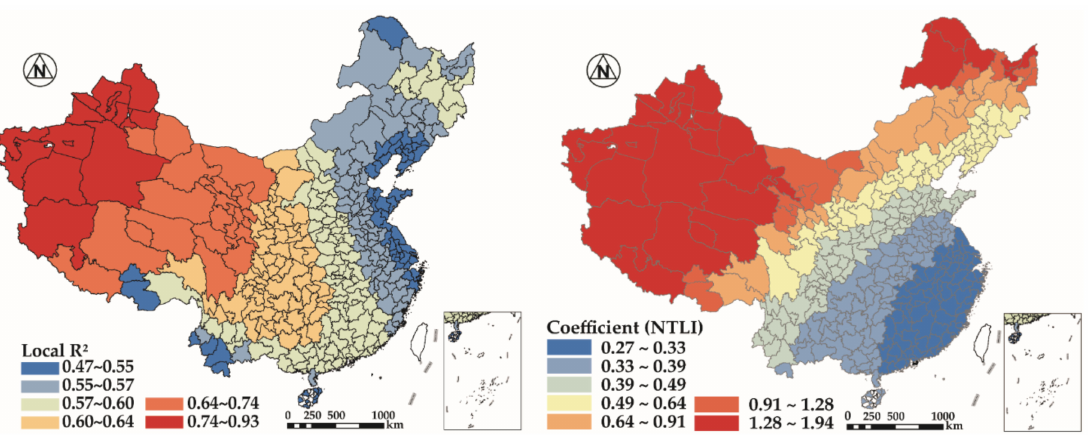
Figure 8. The Local R 2 of GWR and coe ffi cient of Nighttime light intensity at prefectural unit level. (Note: all the coe ffi cients are statistically